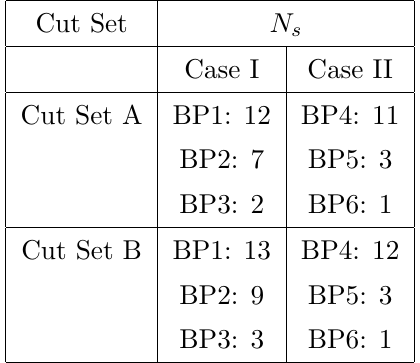
Table 5 . Number of signal events, surviving all the cuts, at an integrated luminosity of 3000 fb (cid:0) 1 for Case I ( m jet + 2 OSSF leptons + =E T (cid:12)nal